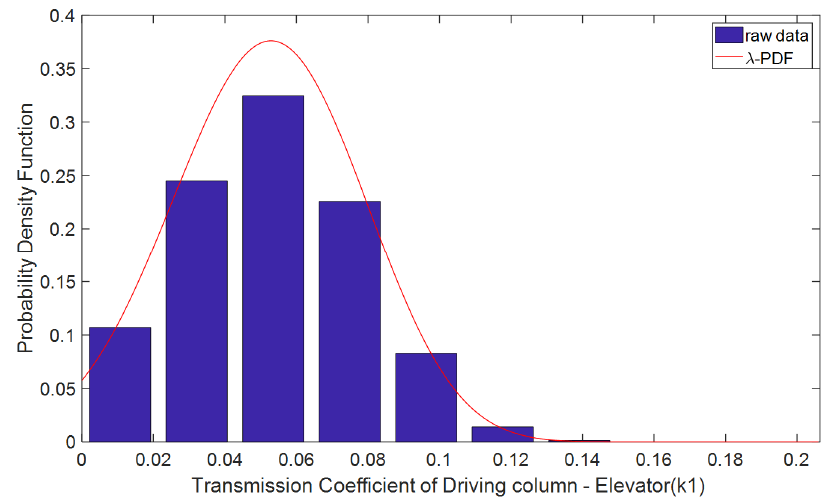
Figure 5. PDF of transmission coefficients from steering column to elevator.